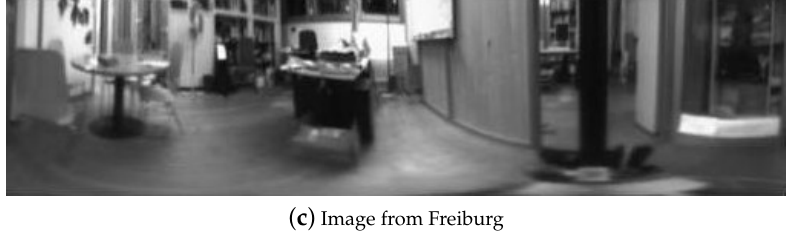
Figure 8. Panoramic images from each of the